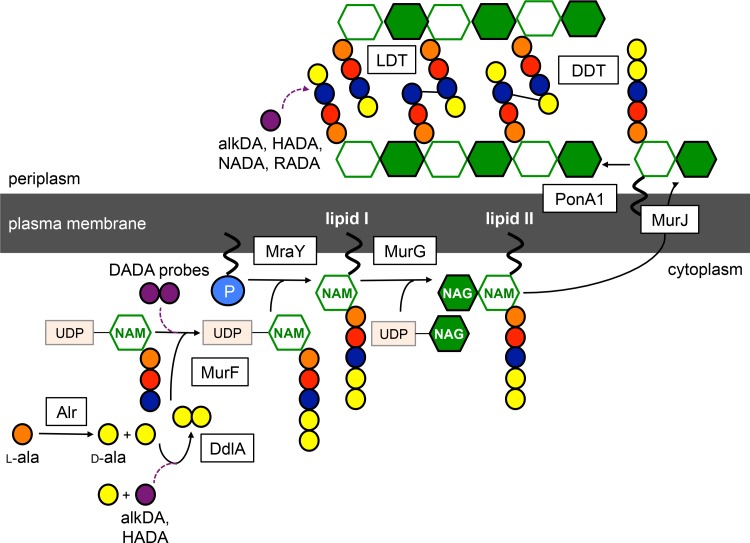
Schematic of peptidoglycan synthesis in mycobacteria.Purple dashed lines, routes of probe incorporation proposed in this work. d,d-transpeptidases (DDT) and l,d-transpeptidases (LDT) respectively catalyze 4–3 and 3–3 crosslinks and can perform exchange reactions with free d-amino acids. Our data support l,d-transpeptidase-mediated exchange as the primary extracellular route of monopeptide probe incorporation into mycobacterial peptidoglycan.